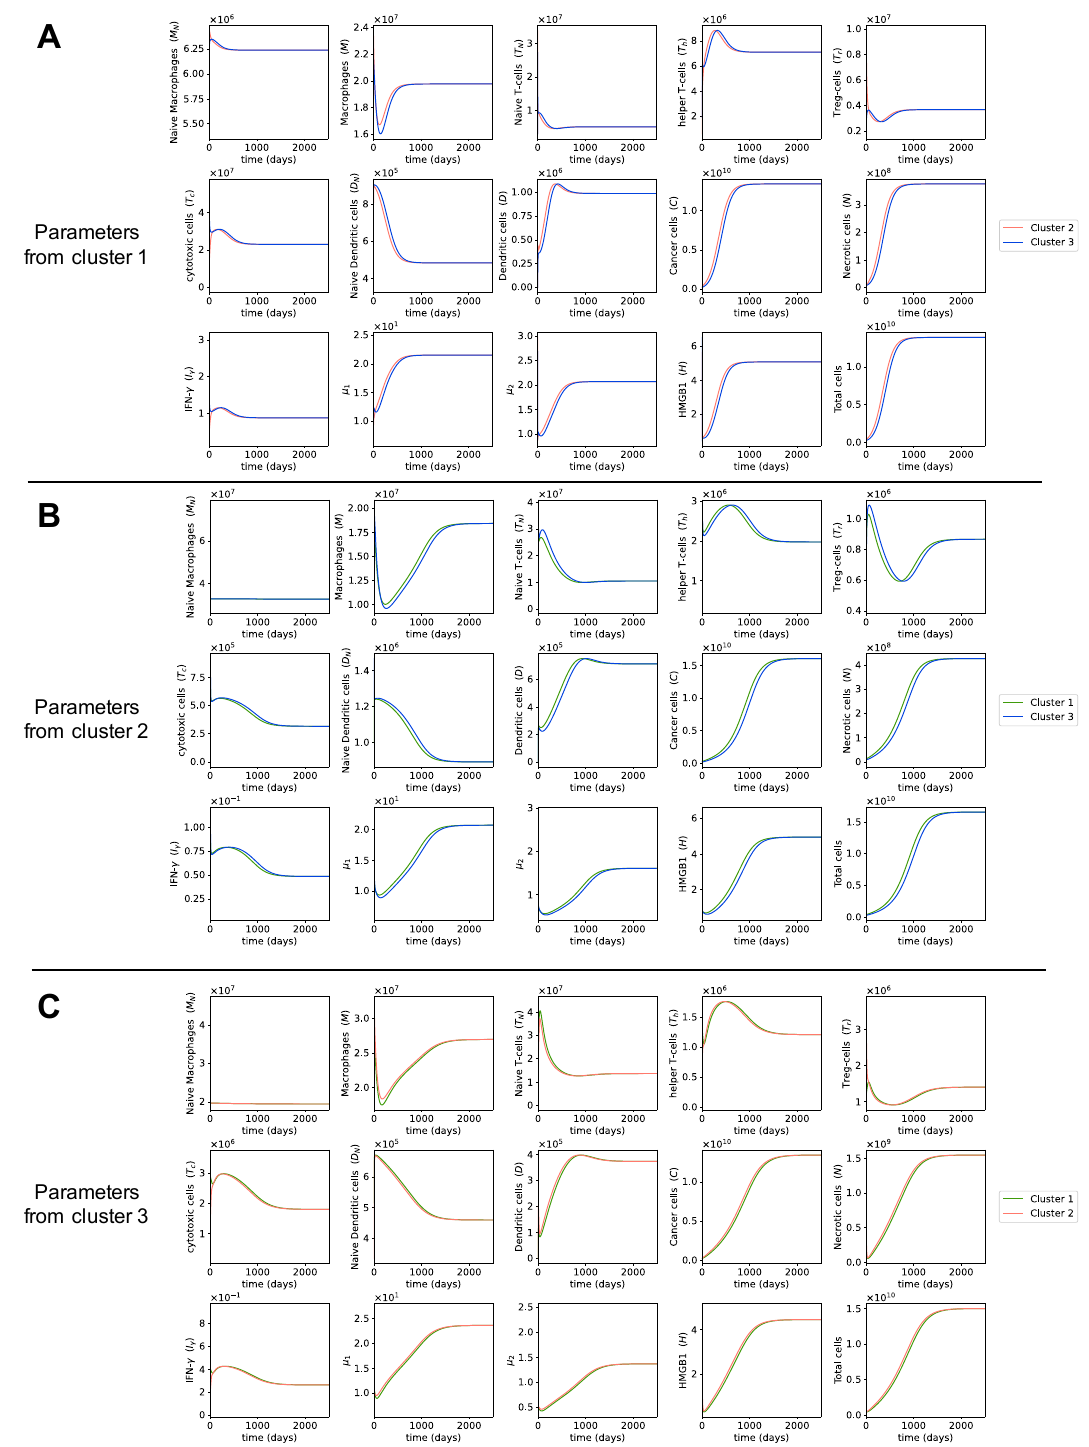
Figure A1. Dynamics with cross-cluster initial conditions. ( A ) The dynamics of cells and cytokines with parameters from cluster 1 and initial conditions from clusters 2 and 3. ( B ) The dynamics of cells and cytokines with parameters from cluster 2 and initial conditions from clusters 1 and 3. ( C ) The dynamics of cells and cytokines with parameters from cluster 3 and initial conditions from clusters 1 and